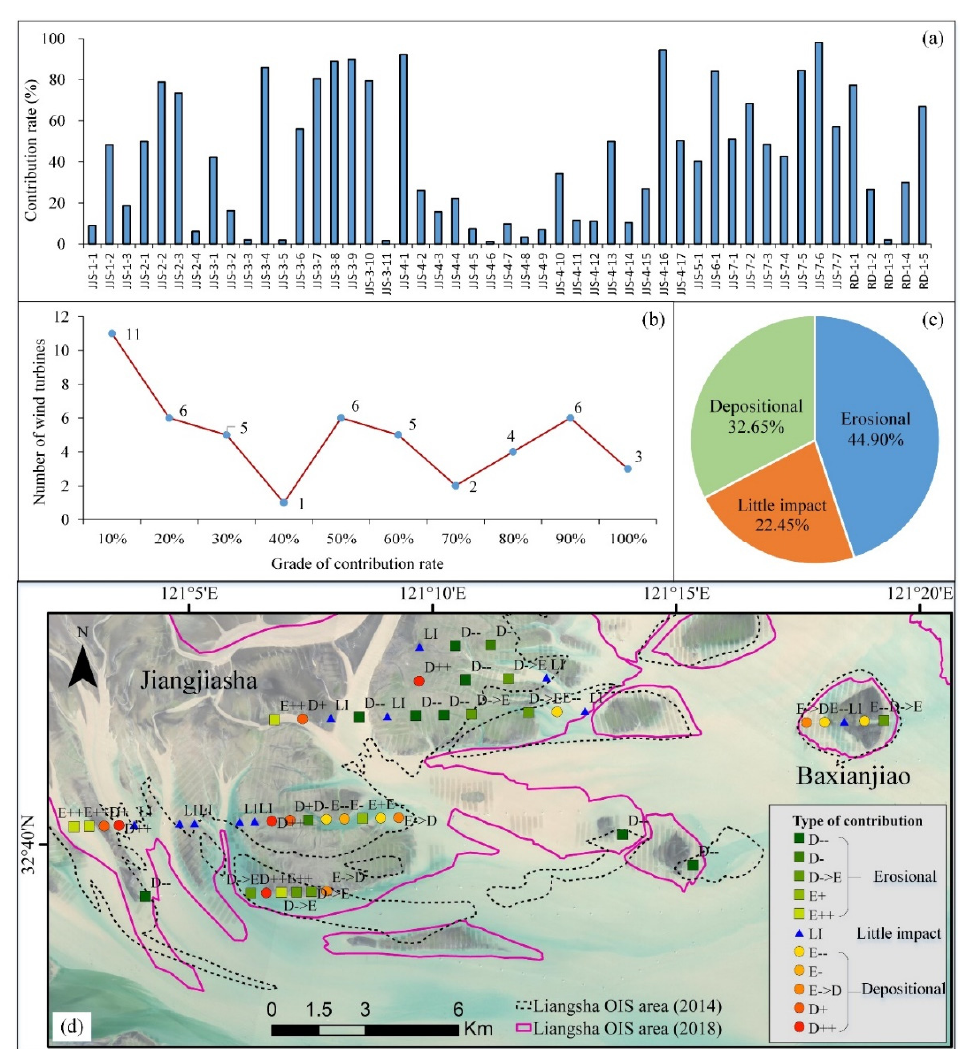
Figure 10. Contribution of terrain changes caused by the construction of wind turbines. ( a ) Con- tribution rates of the 49 OIS wind turbines. ( b ) The number of wind turbines by their grades of contribution rates. ( c ) Terrain change types and their proportions that the wind turbines exerted on the OIS. ( d ) Types of contribution for terrain change at the locations of 49 wind